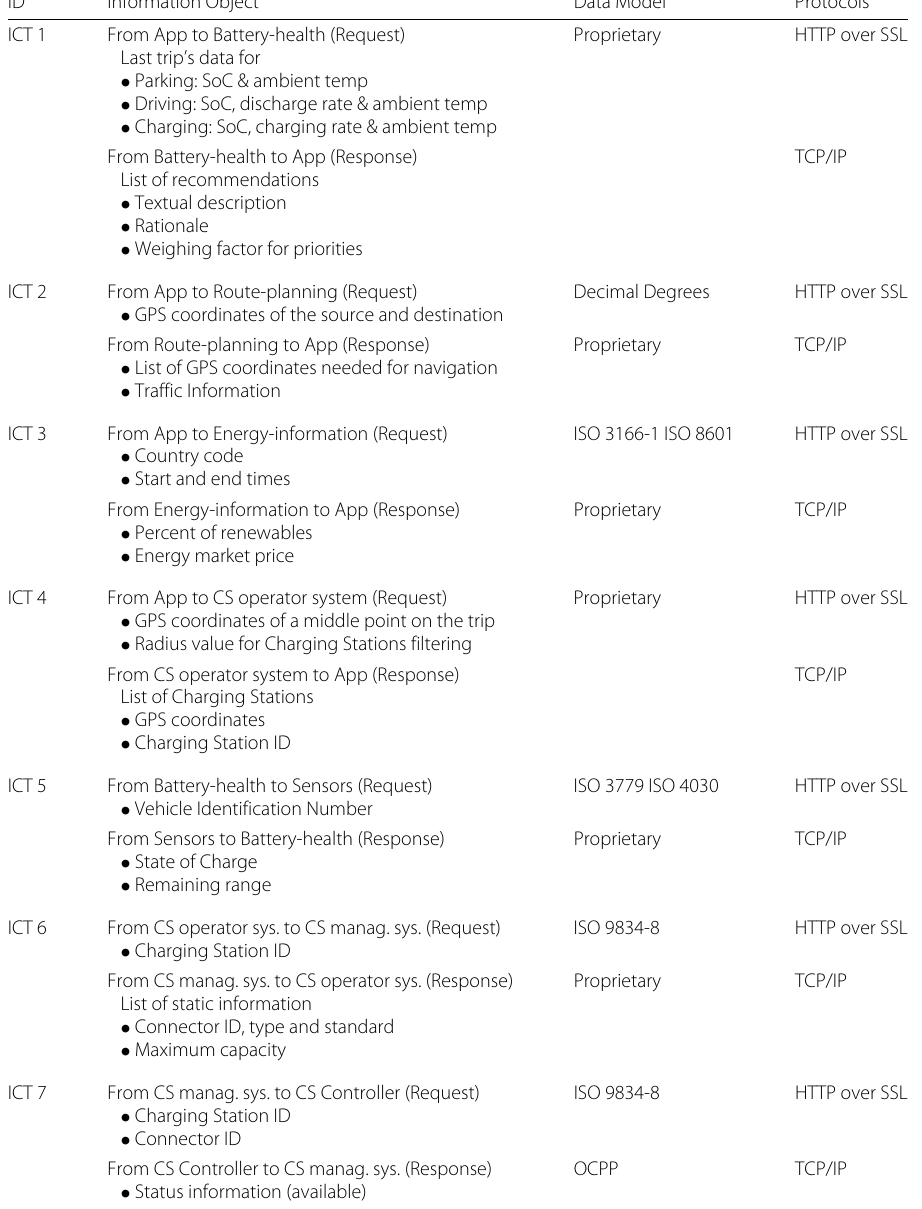
Table 2 Overview of the exchanged information between different components, data models and communication protocols for the high-level